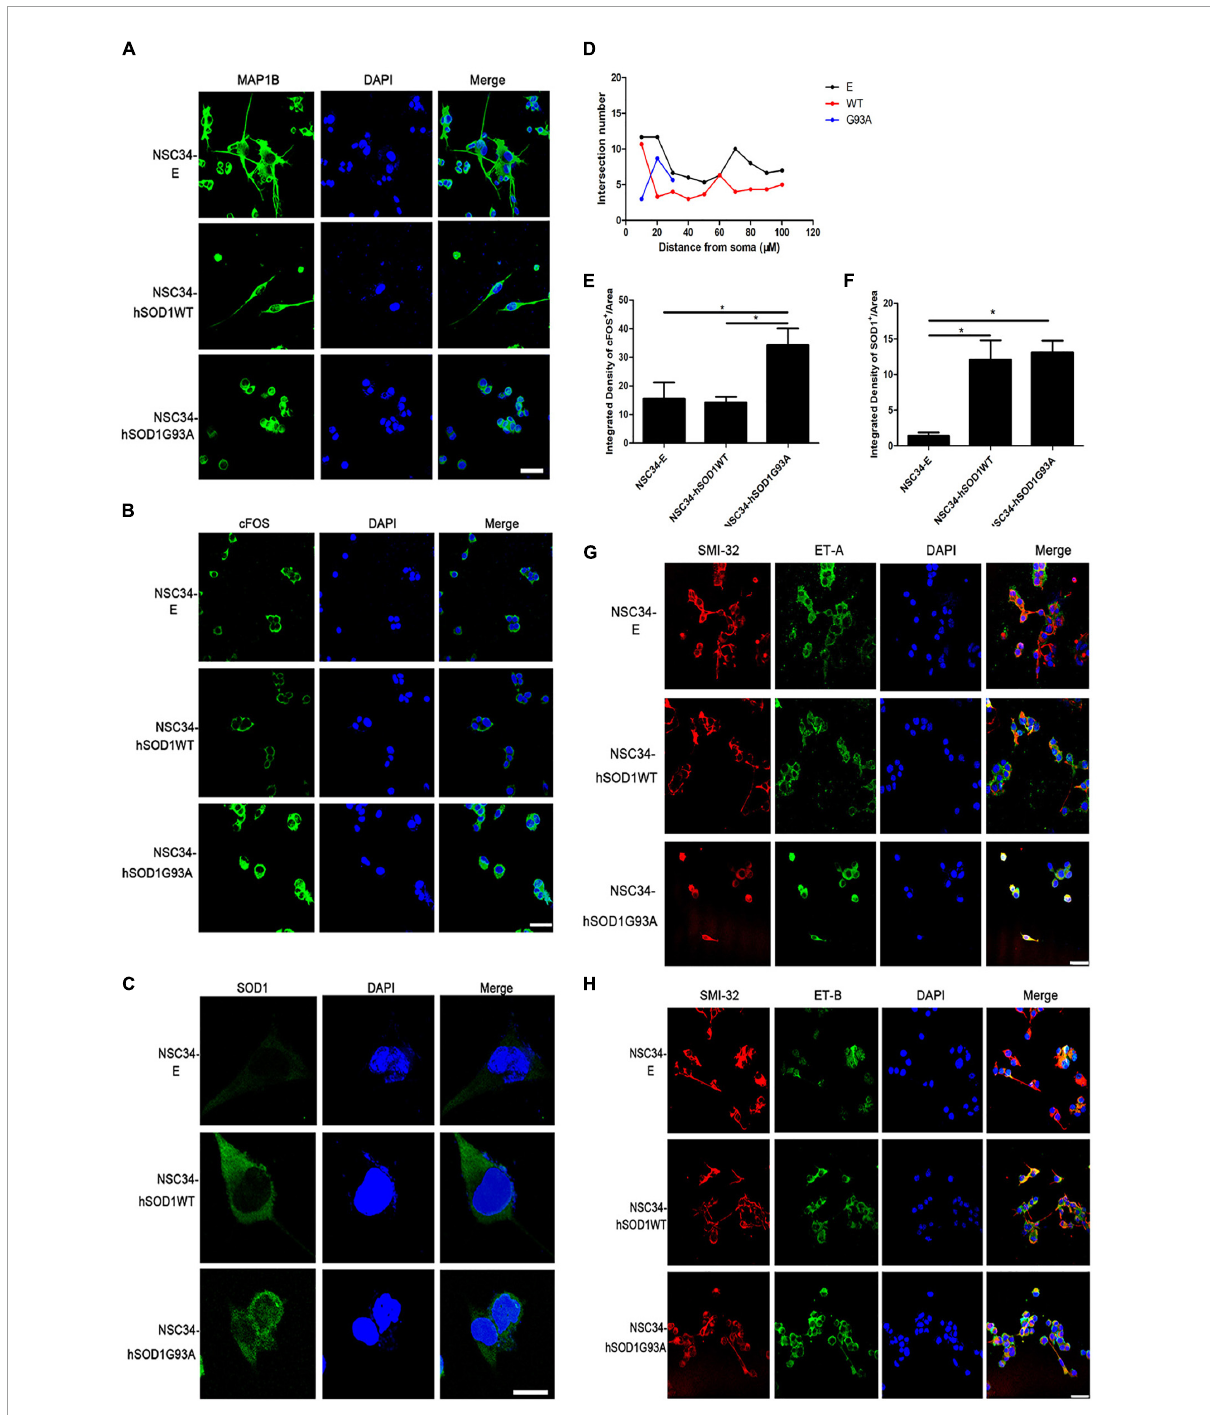
FIGURE4 NSC34-hSOD1G93A cells display a series of injured features and ET-A and ET-B receptors are both expressed in the cell model. (A) Immunofluorescence labeling of MAP1B showing different neurites of the three cell groups (NSC34-E, NSC34-hSOD1WT and NSC34-hSOD1G93A). (B) Immunofluorescence staining indicates increased cFOS expression in NSC34-hSOD1G93A cells. (C) Immunofluorescence staining shows hSOD1-positive aggregates in NSC34-hSOD1G93A cells. (D) Quantification of neurite length from multiple fields of view was analyzed by the Sholl analysis. (E , F) Bar graphs showing quantification of cFOS and hSOD1 fluorescence intensities from multiple fields of view. *P < 0.05, a pairwise comparison marked by a horizontal line. Data represent the mean ± SEM, statistical significance was assessed by one-way ANOVA followed by LSD- t test. (G,H) Similar ET-A and ET-B expression are observed in the three cell groups. Bar = 50 µ m in (A,B,G,H) . Bar = 20 µ m in (C)